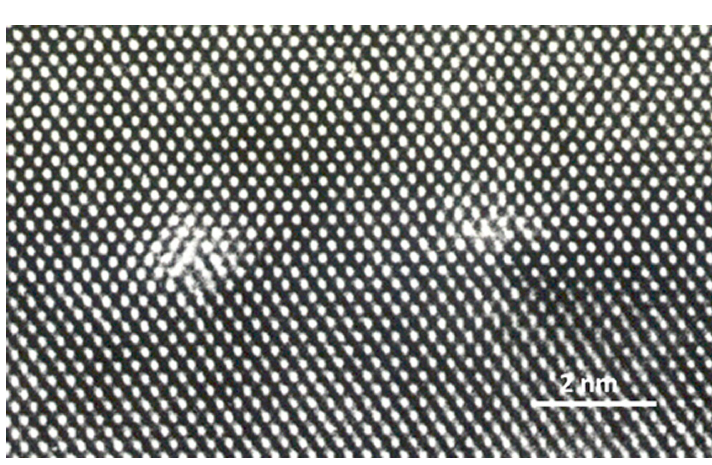
Figure 5. High resolution electron microscopic images of individual dislocations in the interface of a (100)/(100) bonded wafer pair. The cross-sectional samples were prepared parallel to {110}.